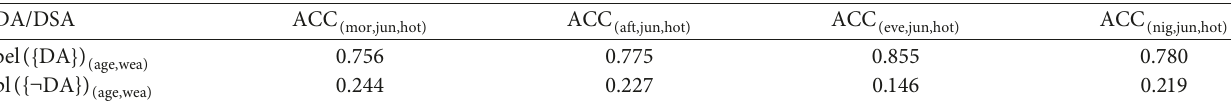
Table 6: Belief values of acceleration subactivity combined with in all periods of day. DA/DSA